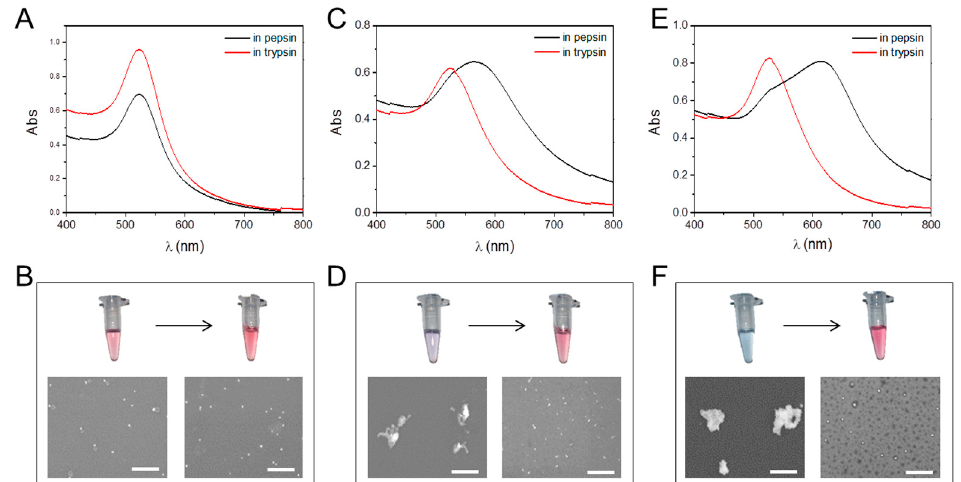
Figure 2. Aggregation of GNPs with di ff erent surface modifications under di ff erent pH values and enzymes present in solution. ( A ) Ultraviolet-visible spectrum of 0% MUA GNPs in pepsin and trypsin. ( B ) Photo and SEM images of 0% MUA GNPs in pepsin and trypsin. ( C ) Ultraviolet-visible spectrum of 50% MUA GNPs in pepsin and trypsin. ( D ) Photo and SEM images of 50% MUA GNPs in pepsin and trypsin. ( E ) Ultraviolet-visible spectrum of 100% MUA GNPs in pepsin and trypsin. ( F ) Photo and SEM images of 100% MUA GNPs in pepsin and trypsin. Scale bar is 500 µm.